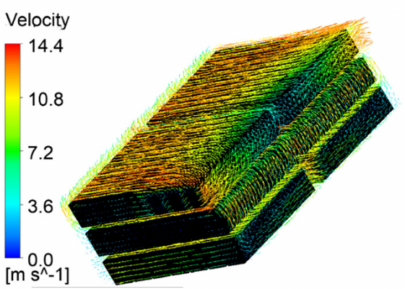
Figure 11. Air flow line diagram in type IV battery pack.